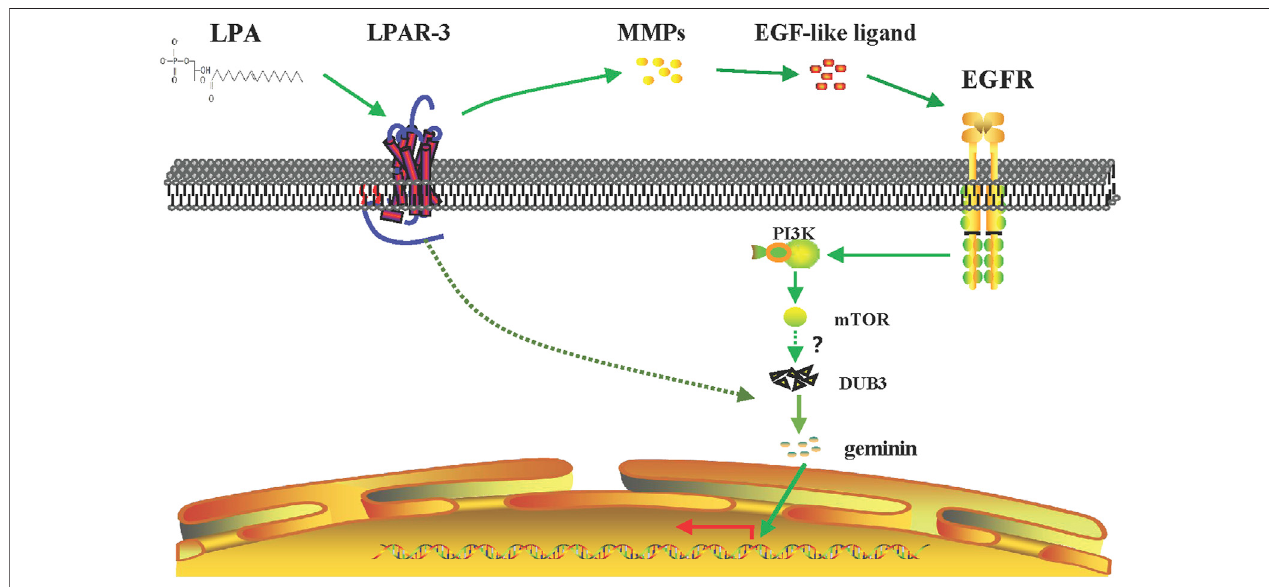
FIGURE9| Signaling pathway ofLPA-mediated DNAreplication initiation. LPAworkthrough LPAR 3 totransactiveEGFRbyMMPsand toincrease theexpression of geminin protein level in the S phase through PI3K/mTOR signaling pathway. Meanwhile, LPA stimulation induces upregulation of DUB3 in a short time, inhibiting the ubiquitination degradation of geminin protein and enhancing its stability, and then positively regulating the DNA replication initiation of gastric cancer cells.